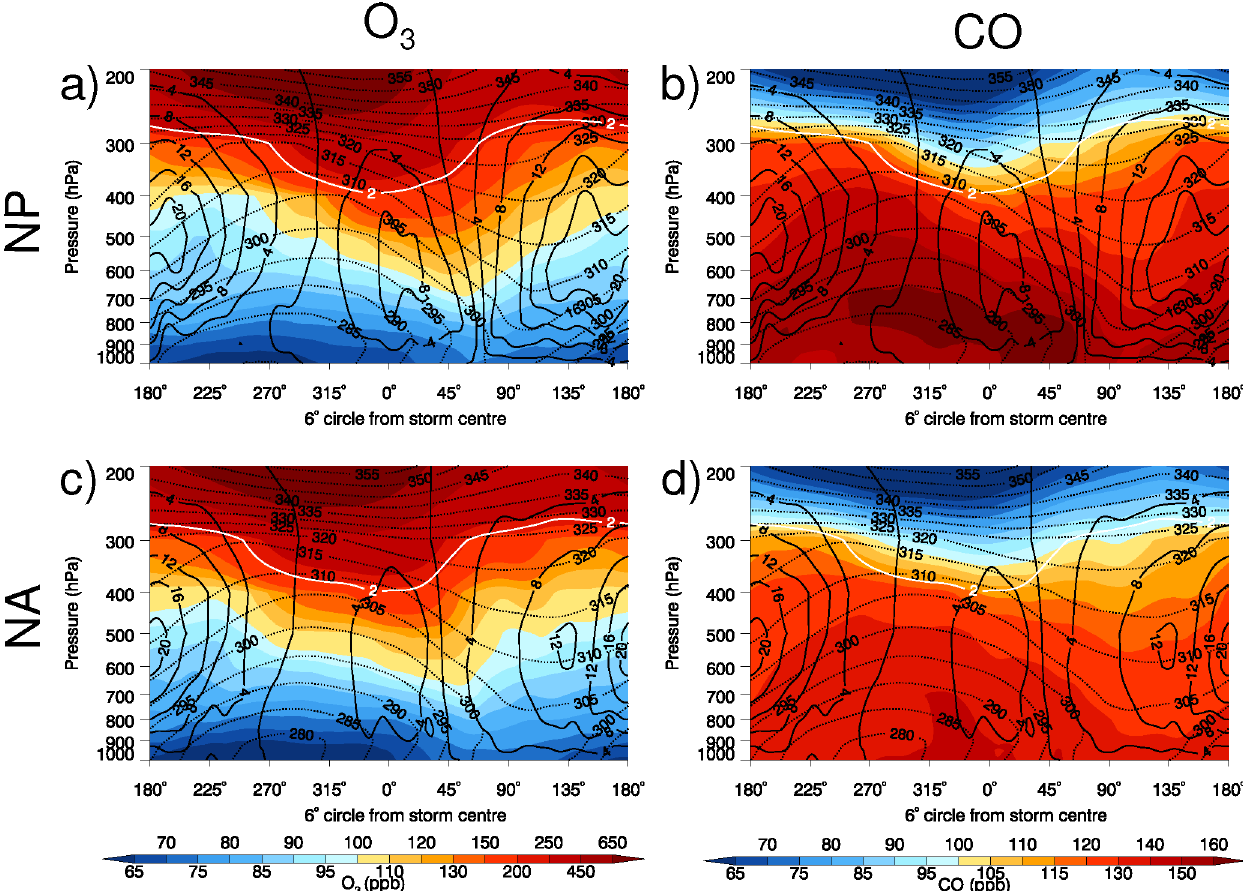
Figure 10. Vertical cylinders at 6 ◦ radius for horizontal composite for (a, b) NP and (c, d) NA 95th percentile MAM storm tracks during 2003–2012. (a, c) O 3 and (b, d) CO (ppb), θ e (dotted contour lines, 5K intervals), ω (solid contour lines; 4hPah − 1 contour intervals, with positive values indicating ascent), and the isosurface of 2 PVU (solid white line) are